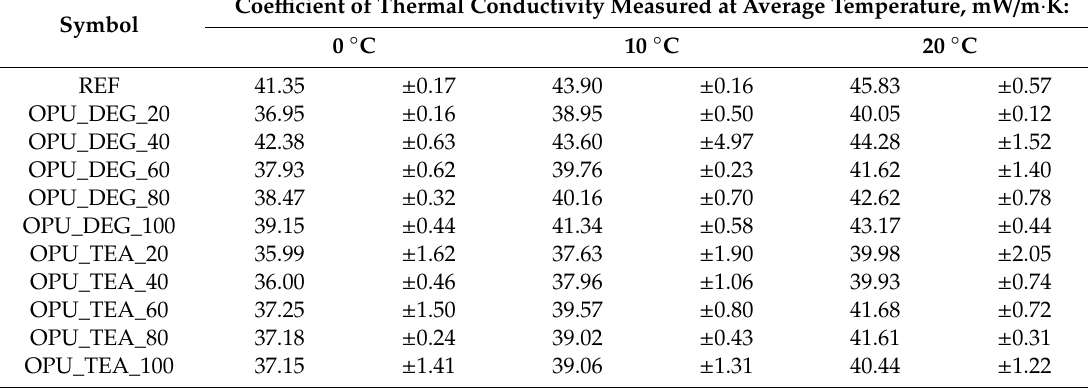
Table 3. Coe ffi cients of thermal conductivity of